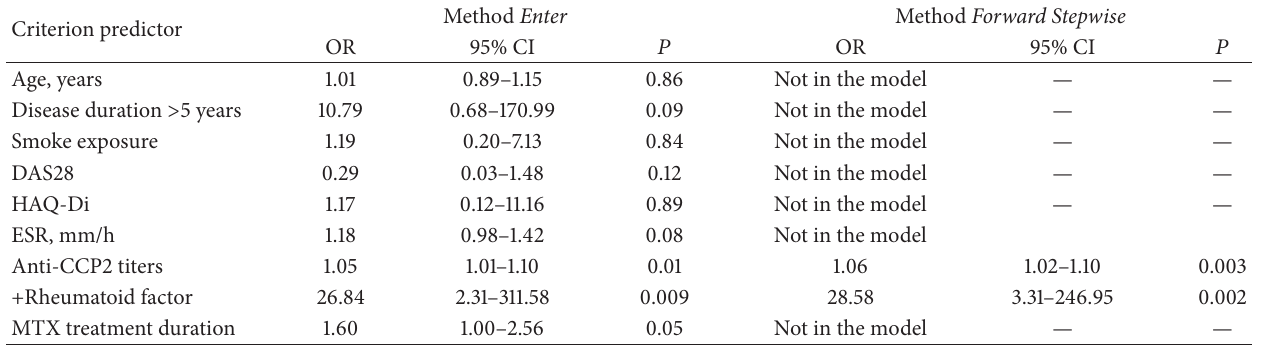
Table 3: Logistic regression analysis performed to assess the risk factors associated with the RA-ILD.